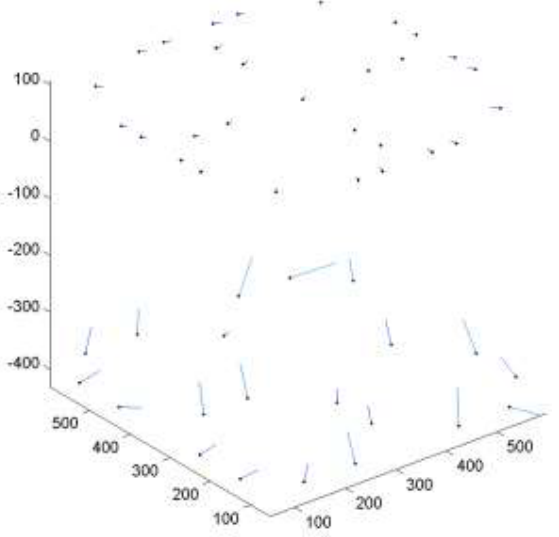
Figure 4: Representative 3D residual plot (here: 12MB dunk GT, test 5) with removed systematic trend. Units are in mm with an enhancement factor for the residuals of